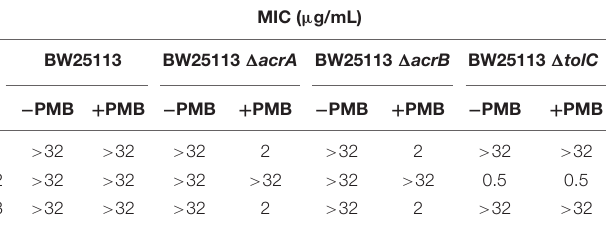
TABLE 1 | Antibacterial activity of the most potent three UppS inhibitors against wild-type and efflux pump-deficient E. coli BW25113 strains with ( + PMB) or without ( − PMB) polymyxin B-formed permeable membrane.